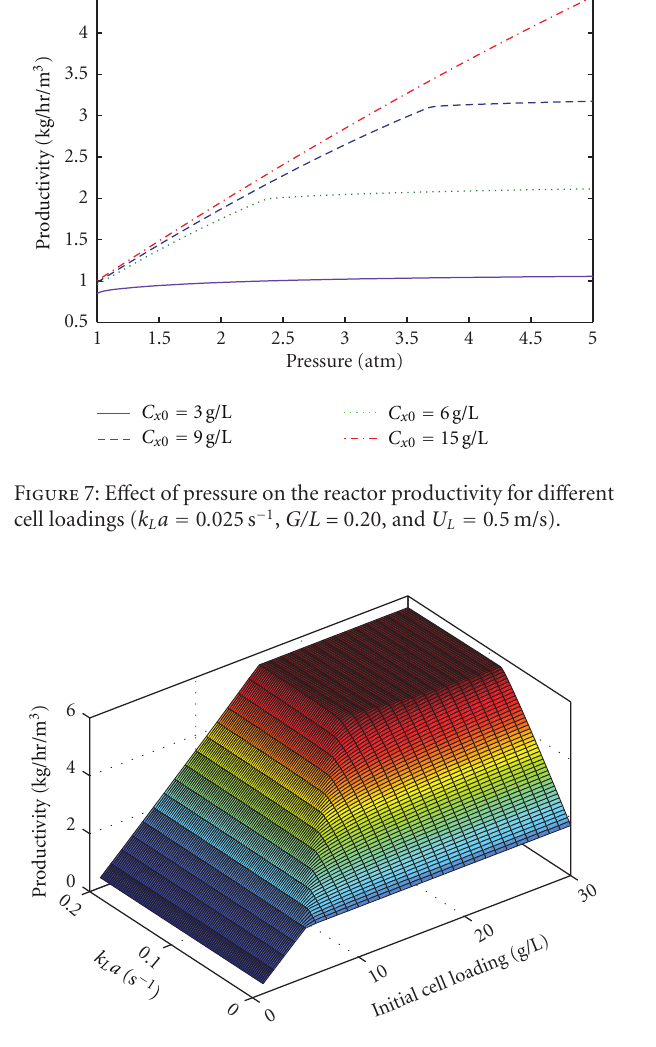
Figure 8: E ff ect of initial cell loading and volumetric mass transfer coe ffi cient on the productivity of the bioreactor ( P T = 3atm, G/L = 0.20, and U L = 0 . 5 m/s).